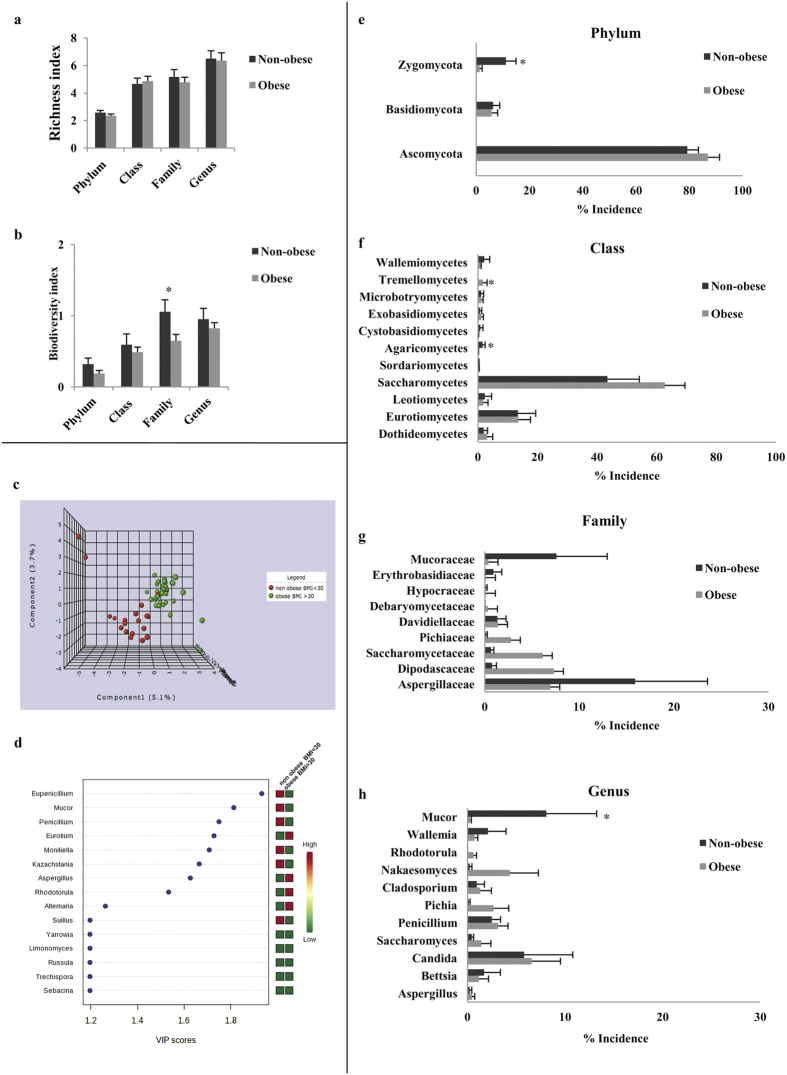
Fungal distribution in obese and non-obese subjects.(a) Fungal richness and (b) fungal biodiversity observed in obese and non-obese faecal samples. (c) Mycobiota genus abundance defined by PLSDA in obese and non-obese individuals. (d) Variable importance in projection of the first component of the PLSDA model. Frequencies of detected fungi in each phylum (e), class (f), family (g) and genus (h) between obese and non-obese patients. Mean values ± s.e (bars) are plotted, *p < 0.05.